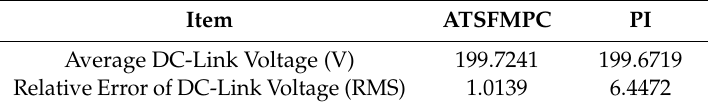
Table 2. Comparison of DC-link voltage regulation performances for Northwest European